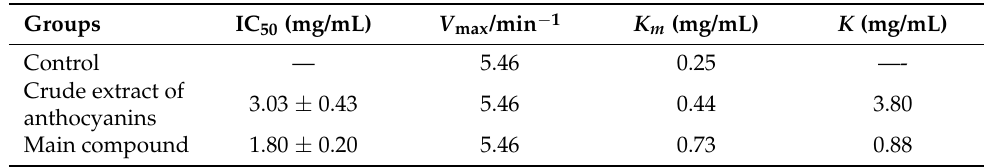
Figure 5. The changes in the gut microbiota structure at the genus level. Data are expressed as the mean ± SD ( n = 8 for each group), ** denotes p < 0.01. ( a ) The accumulative abundance of the top 10 genera among the different groups. ( b ) The relative abundance of Faecalibaculum . ( c ) The relative abundance of Akkermansia . ( d ) The relative abundance of Dubosiella . ( e ) The relative abundance of Blautia . Table 3. The IC 50 and kinetic parameters of pancreatic lipase in the presence of different anthocyanins from the fruit of L. ruthenicum